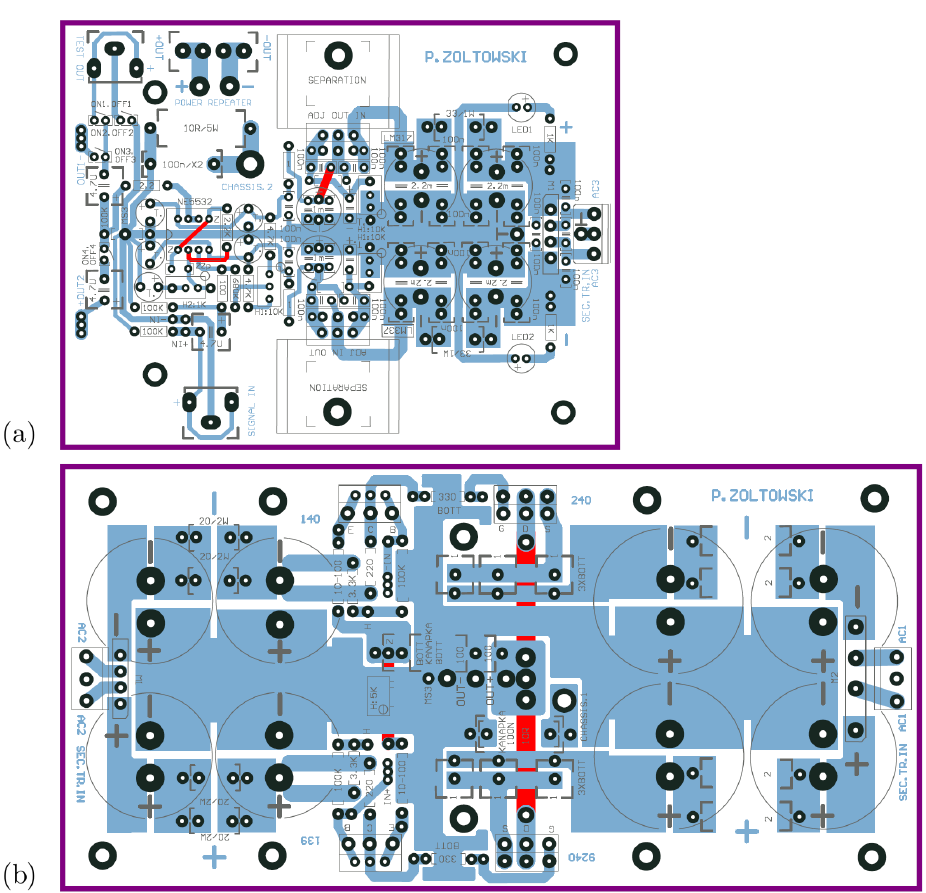
Figure 5. PCB layout design: ( a ) board with a preliminary amplifier system; and ( b ) LF amplifier